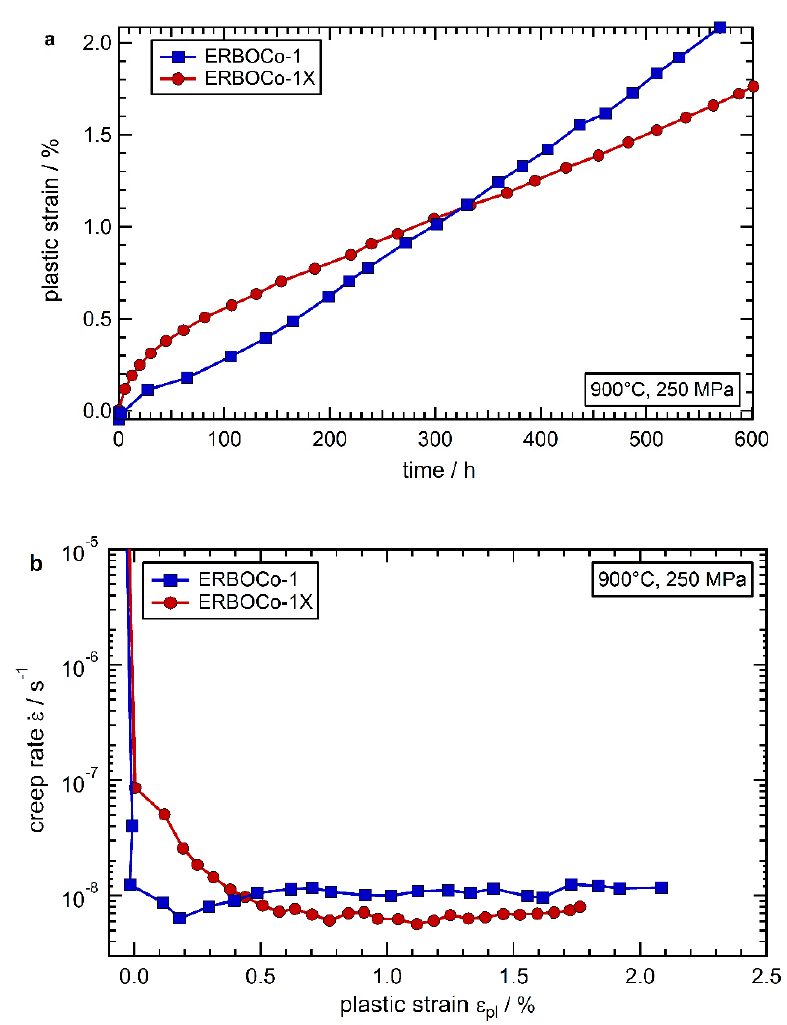
Figure 6. Compressive creep properties of ERBOCo-1 and ERBOCo-1X at 900 °C and 250 MPa: ( a ) plastic strain as a function of time, ( b ) creep rate as a function of plastic strain.